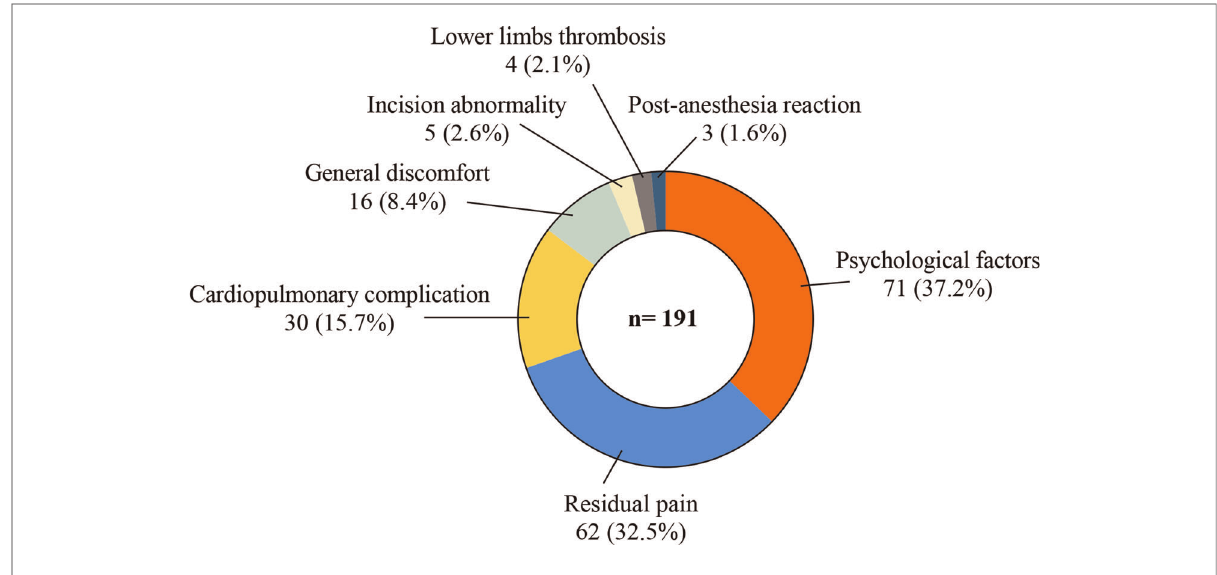
FIGURE 2 Reasons for delayed discharge.